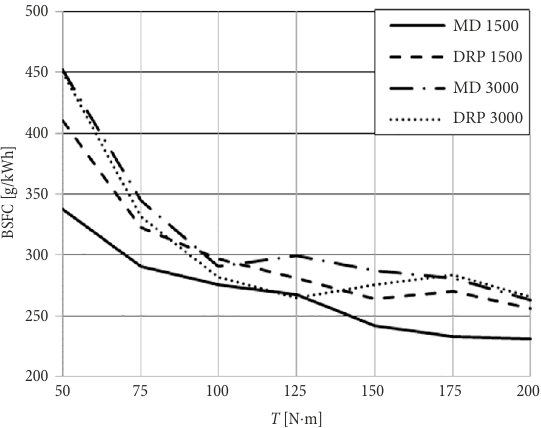
Figure 14. BSFC vs engine load for MD and DRP at 1500 rpm and 3000 rpm